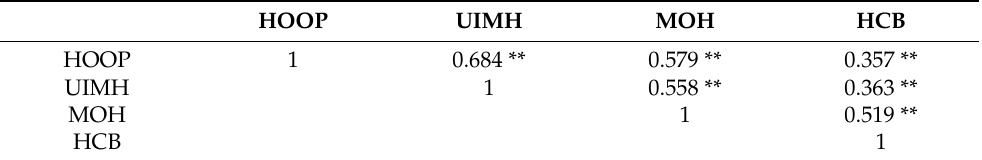
Table 4. Correlation analyses between the scales.